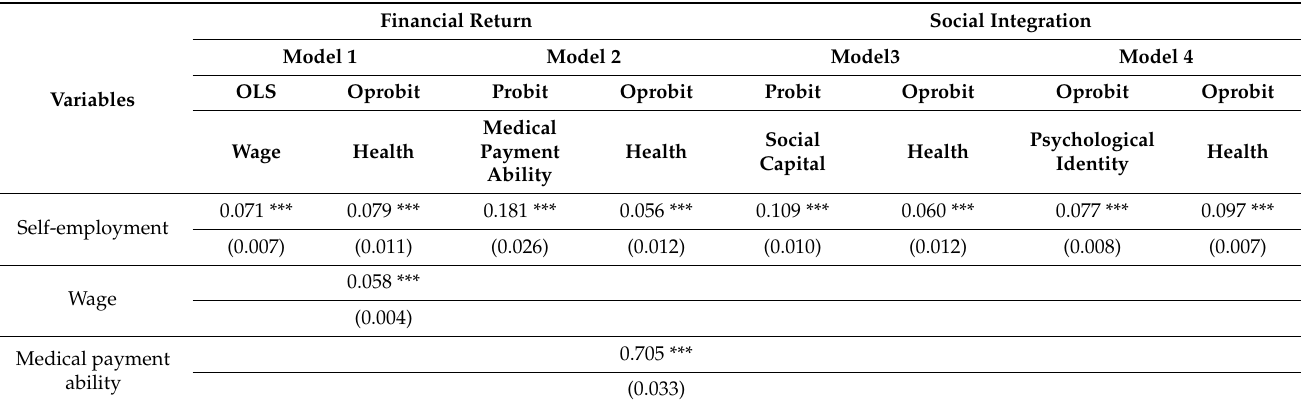
Table 9. The results of indirect